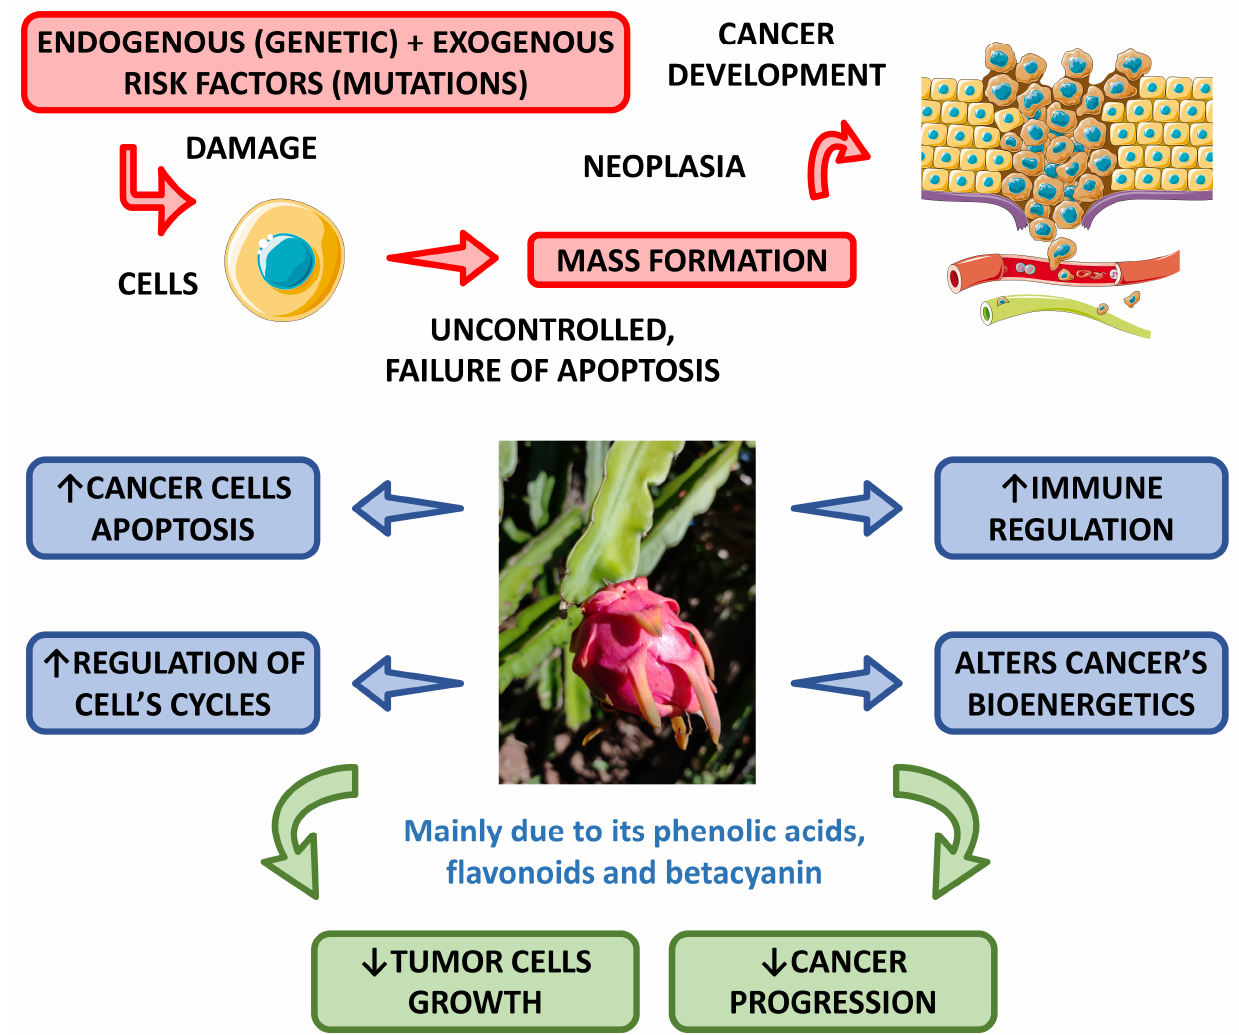
Figure 6. Main anti-cancer effects of Hylocereus species. ↑ —increase; ↓ Figure 6. Main anti ‐ cancer effects of Hylocereus species. ↑ —increase; ↓ —decrease.